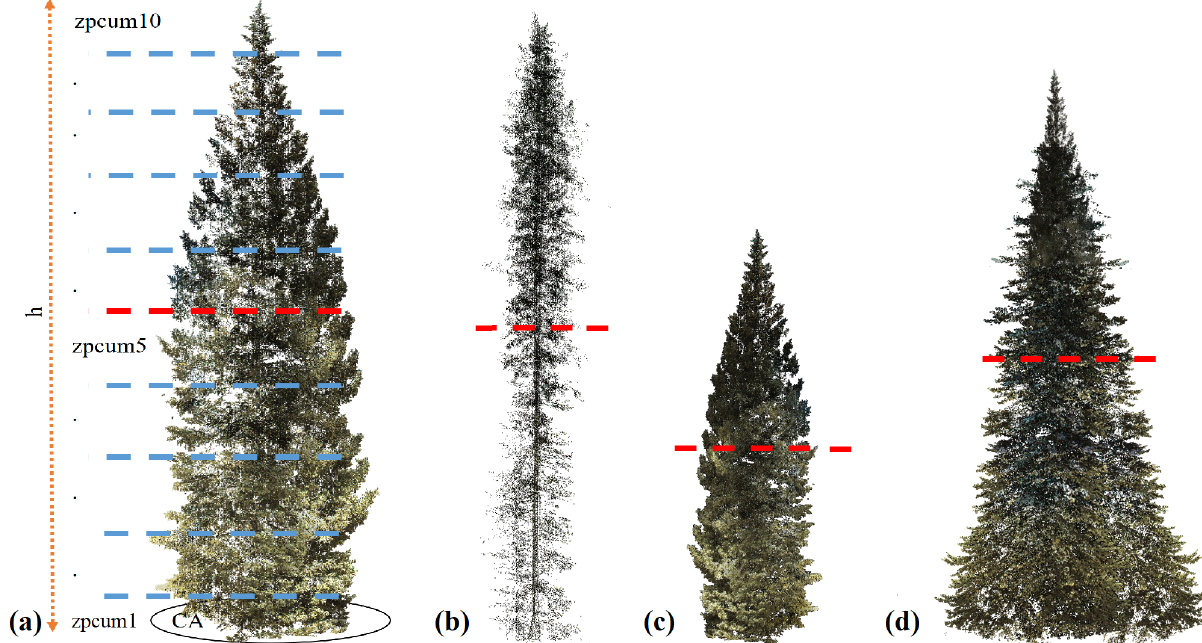
Figure 4. Graphical examples of trees with different structures and the metrics of foliage height diversity (FHD), crown volume, and the cumulative percentage of vegetation returns (zpcum). Crown volume is estimated using crown area (CA) multiplied by height ( h ). Zpcum is based on 10 layers (zpcum1–zpcum10) (see example in panel a ). The dashed red lines are examples of the cumulative layer with > 50% of vegetation returns. The foliar complexity (FHD) of panels (a) and (c) is similar but the crown volumes and cumulative percentage of vegetation returns are different, whereas the FHD of panel (b) is the